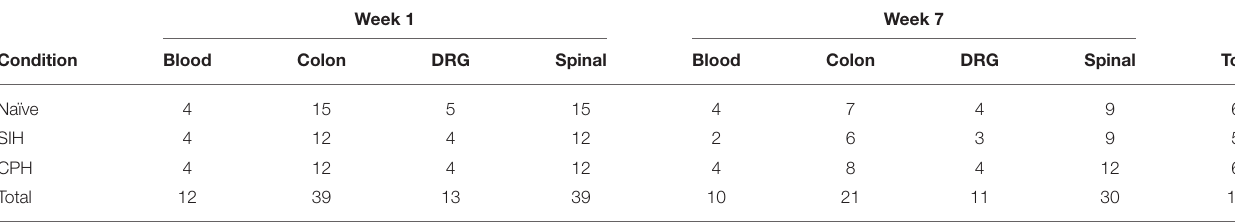
TABLE 1 | Samples stratified by condition, tissue, and time elapsed since stress induction.